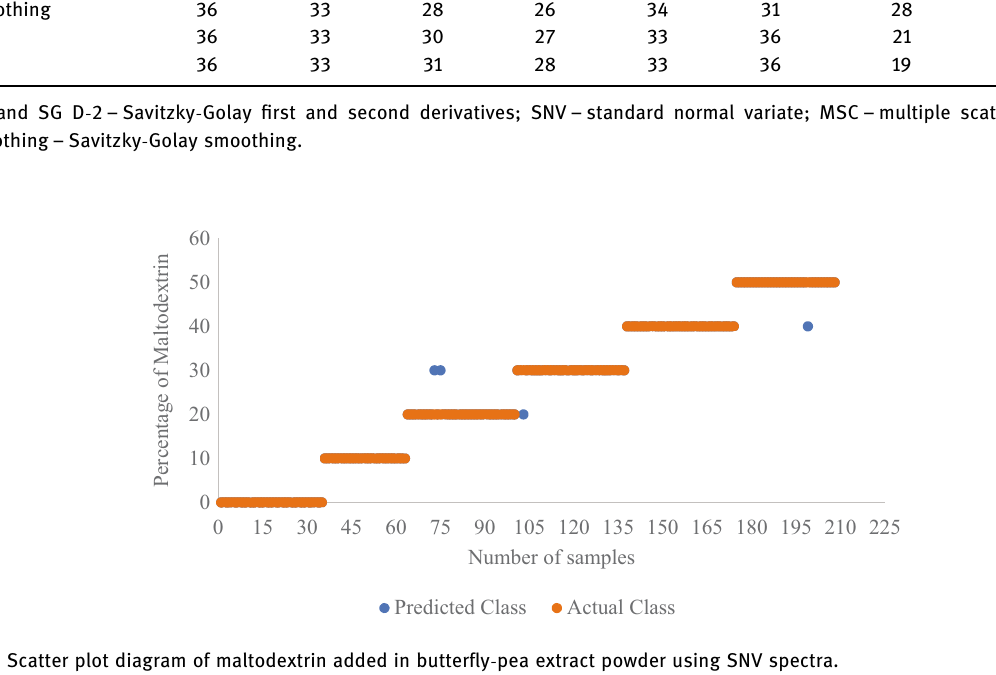
Pre - processing method